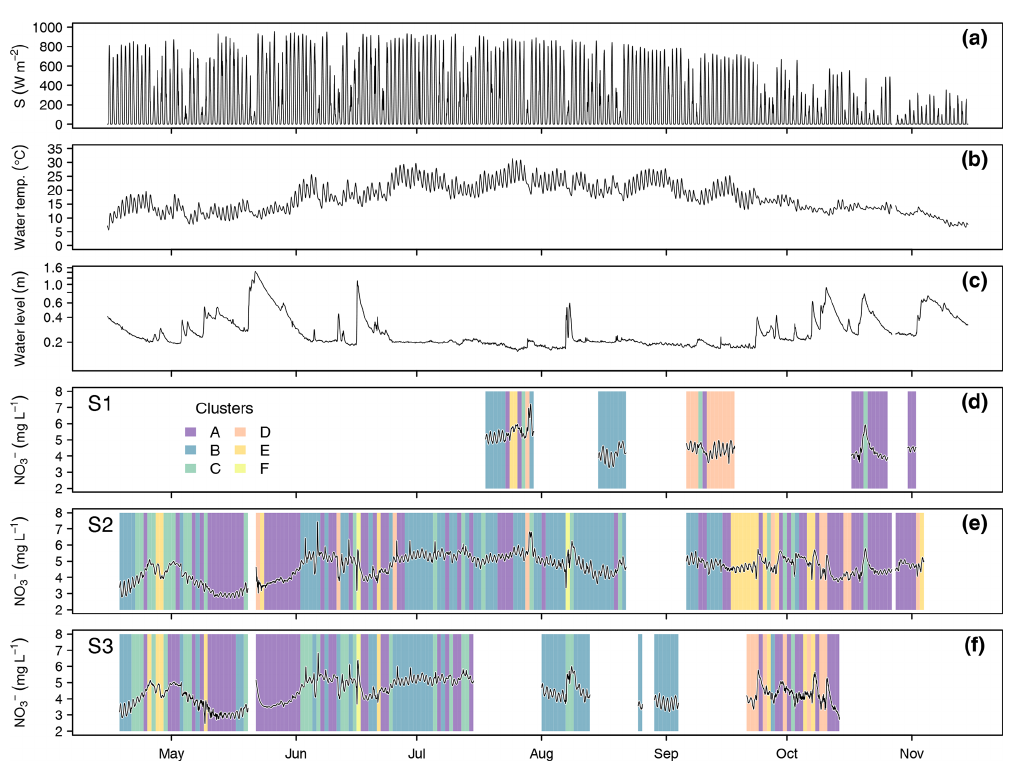
Figure 3. Global irradiance (a) , water temperature (b) , and water level (c) at S3 as well as NO − monitoring sites S1 (d) , S2 (e) , and S3 (f) . Background colors in (d) to (f) indicate to which cluster the corresponding day was